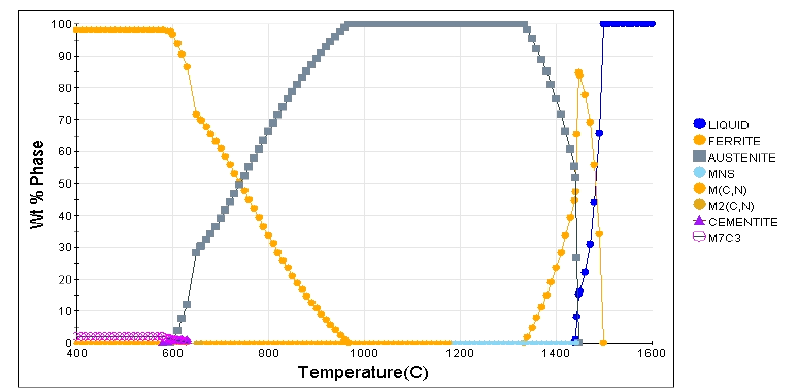
Figure 4. Equilibrium evolution of phases in 5 Mn steel calculated using the JMatPro package.